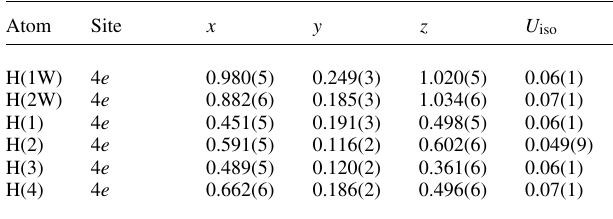
Table 2. Atomic coordinates and displacement parameters (in Å 2 ) . Table 1. Data collection and